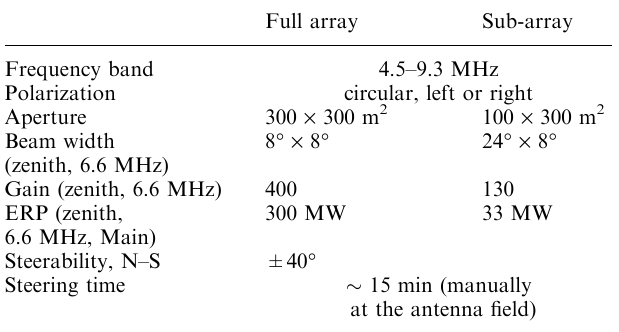
Table 1. SURA heating facility antenna